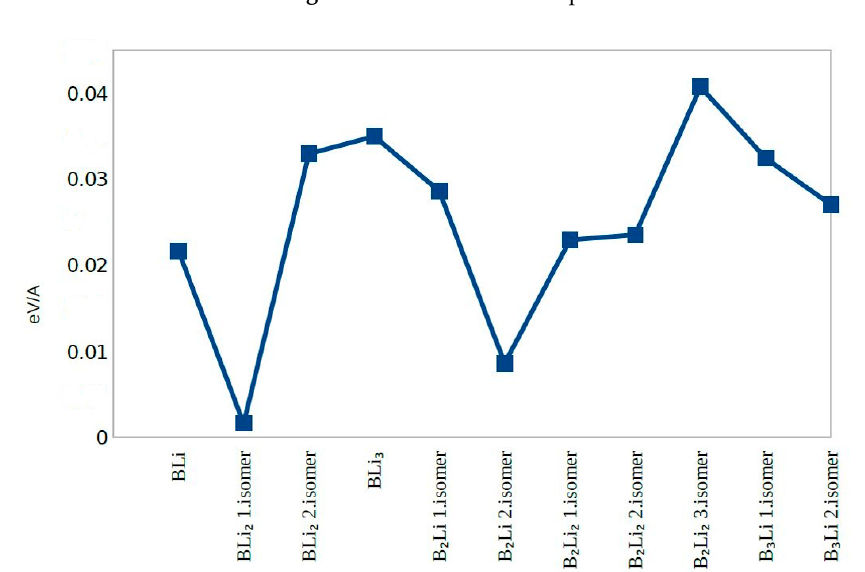
Figure 2. HOMO-LUMO Gap.